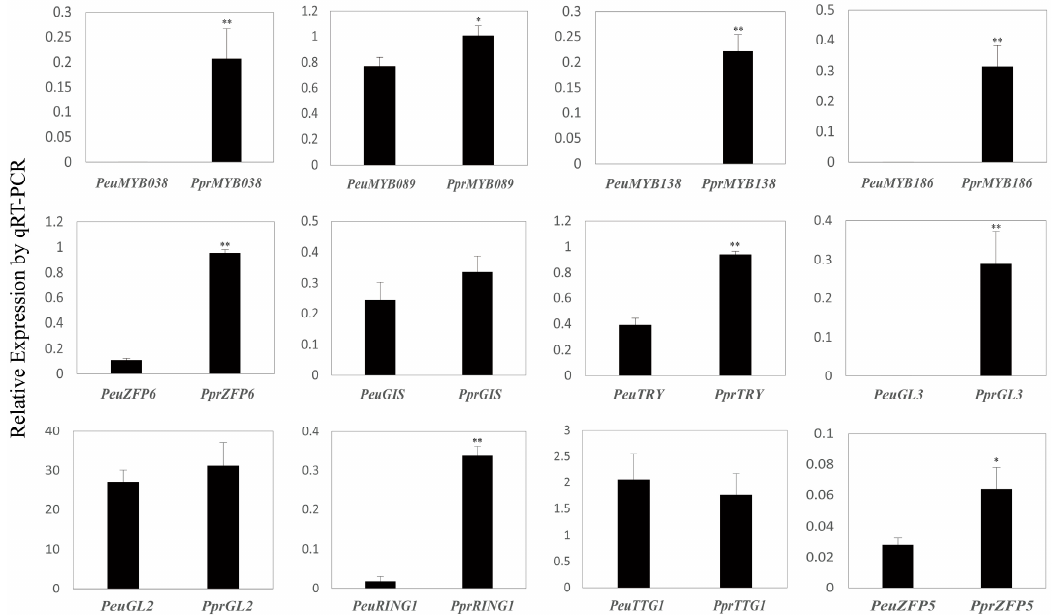
Figure 7. Verification of transcriptome data by quantitative real ‐ time PCR (qRT ‐ PCR). Eight gene pairs related to trichome formation were selected for qRT ‐ PCR verification. All showed similar patterns of expression to those identified from transcriptome data. The vertical bars indicate standard deviations. Asterisks indicate statistically significant differences using Student’s t ‐ test (**: p < 0.001; *: p < 0.05).